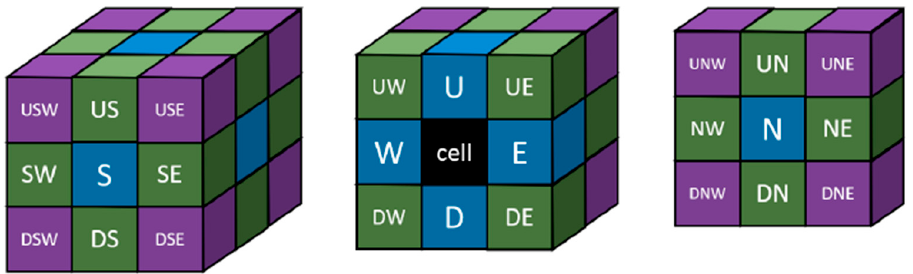
Figure 19. Graphical representation of Moore’s neighbourhood for the 3D CA; each of the letters corresponds to directions: North, South, East, West, Up, Down with reference to the black cell. Thus, the time of gelation can be expressed in the form of Equation (2), where 𝐴 is a constant dependent on the Arrhenius constant. This representation of the Arrhenius equation allows the establishment of 𝐴 and 𝐸 values [13,56], thus the reaction probabil- ity for a specific experimental synthesis. More information on the evaluation of model parameters is presented in the following sections. If the reaction between adjacent parti- cles does indeed occur, these particles start to act as one aggregate (particles that belong to different aggregates may also react with one another). The last parameter 𝑃 (cid:3003) is the probability of breakage between adjacent, connected particles, although this aspect is not taken into a consideration within the presented model. 4.3. Kinetics Simulation As mentioned in Section 1, DLCA/RLCA modelling was not originally intended to investigate the system’s kinetics but to study the structure formation. In our case, it was the main objective to develop an algorithm that would be analogical and comparable with experimental measurements. Therefore, we focused on the mechanism of spectro- photometric measurement. During gelation, at first, the reaction mixture is transparent. As the reaction progresses, clusters of repeating units are formed, and when they reach a certain, not yet quantified size, they appear to be visible in the UV-Vis spectrum. The sample gradually becomes turbid, causing an increase in the sample’s absorbance value. In the presented numerical system, when an aggregate reached a detectable size (i.e., consisted of a set number of particles), its mass was added to the total sum of the con- densed product and, thus, the condensation kinetics curve increased. An important as- pect was defining a detectable size to correlate properly with experimental measure- ments. Three values were chosen to be tested: (i) a detectable size equal to 1% of a total number of secondary particles, (ii) equal to 2.5%, and (iii) equal to 4%. This approach for detectable size definition allows for the scaling of the parameter due to the concentration value or computing domain size. The kinetics curves registered for these three cases are presented in Figure 20A–C and an overall comparison is shown in Figure 20D. Referring to our previous studies [45], a gelation point for previously investigated synthesis was observed when absorbance reaches approximately 99% of its maximum value, and the gel point is usually located right after the inflexion of a curve (presented in Figure 6a and included in reference [45]). Considering all these facts, the detectable size was chosen as 1% of a system’s total number of secondary particles. One should be aware of the arbi- trary character of this parameter. However, it seems as a good initial assumption. The kinetics designation procedure continued until all particles were connected to form one big aggregate.